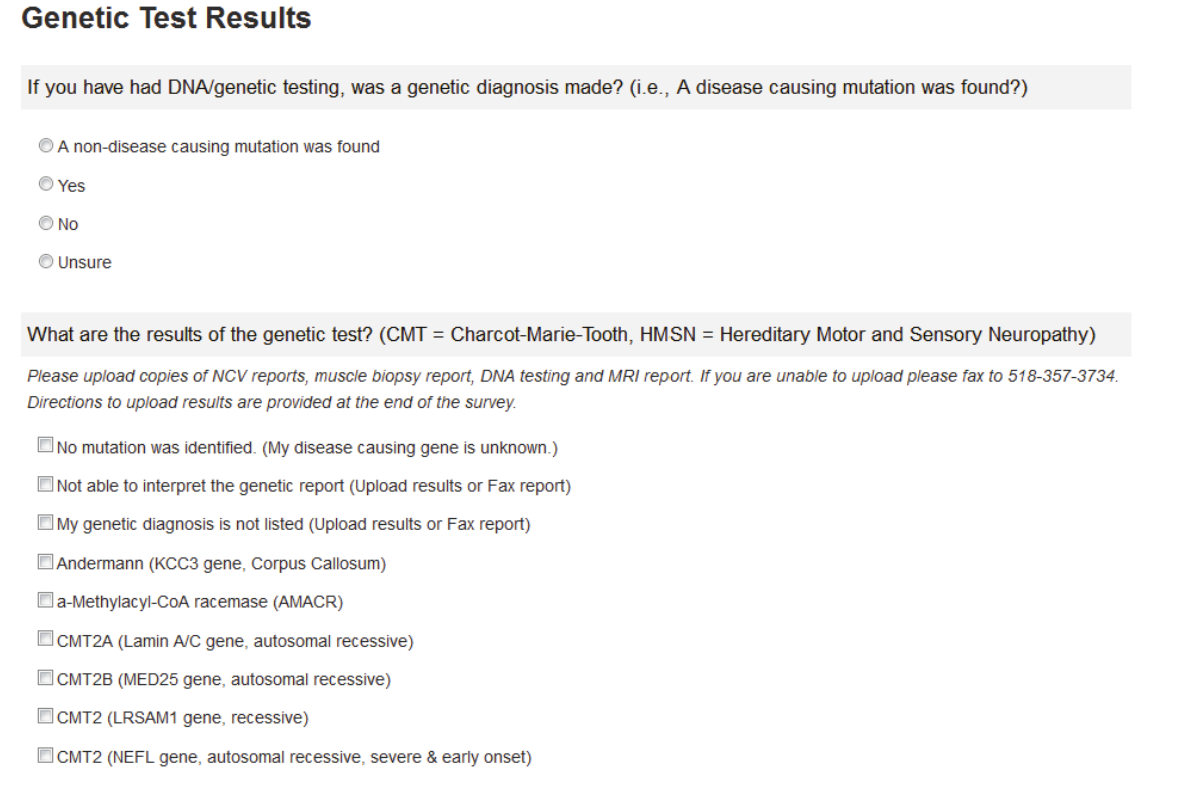
Supplemental Figure 2. Genetic